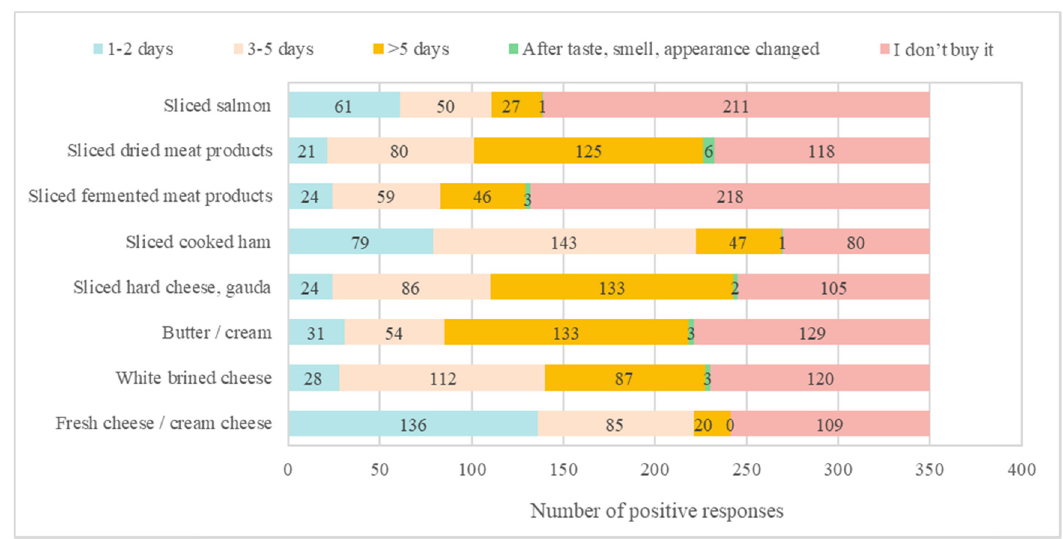
Figure 5: Results to the question “ For how long do you usually store in the refrigerator cut - at - order food items ( bought at delicatessen or open market ) ? ” ( The respondents ( N = 350 ) could select only one option )